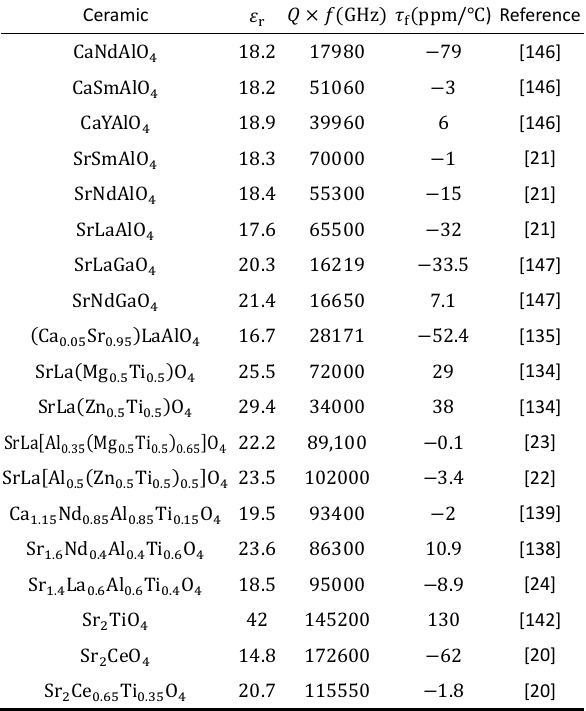
Table 2 Dielectric properties of some recently studied ceramics for low-loss microwave applications